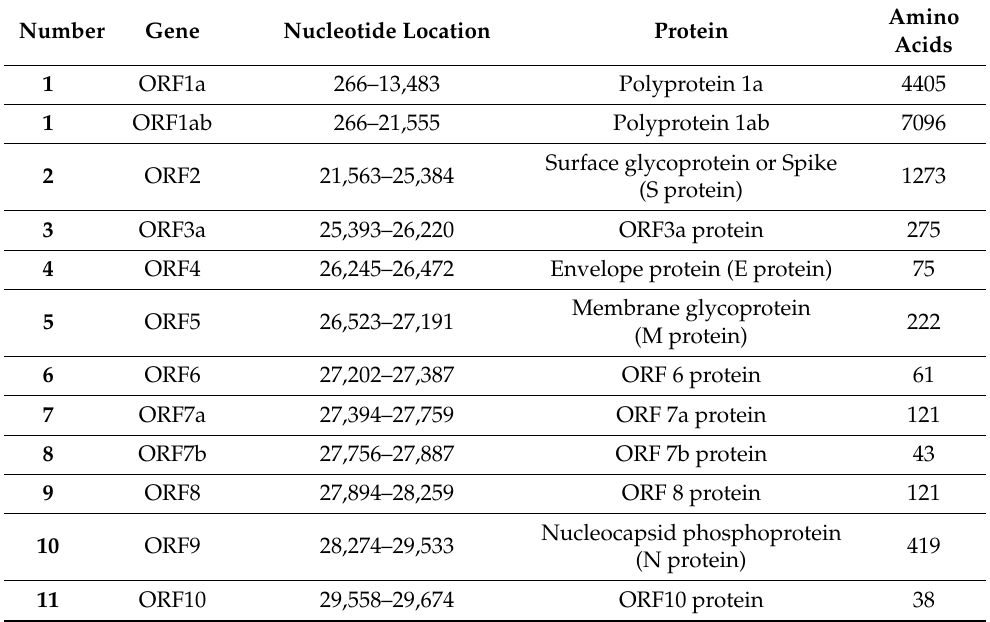
Table 1. Genes and proteins expressed by